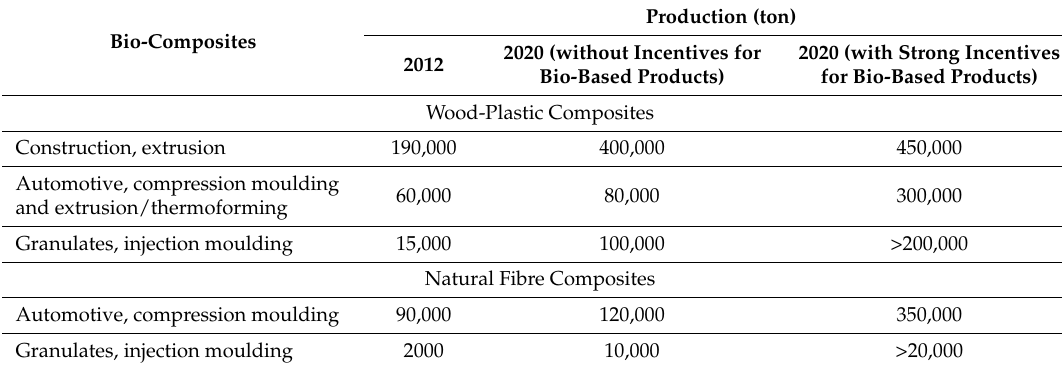
Table 11. Production (in ton) of wood based and natural fibre composites in 2012 and their forecast for 2020. Adapted from: